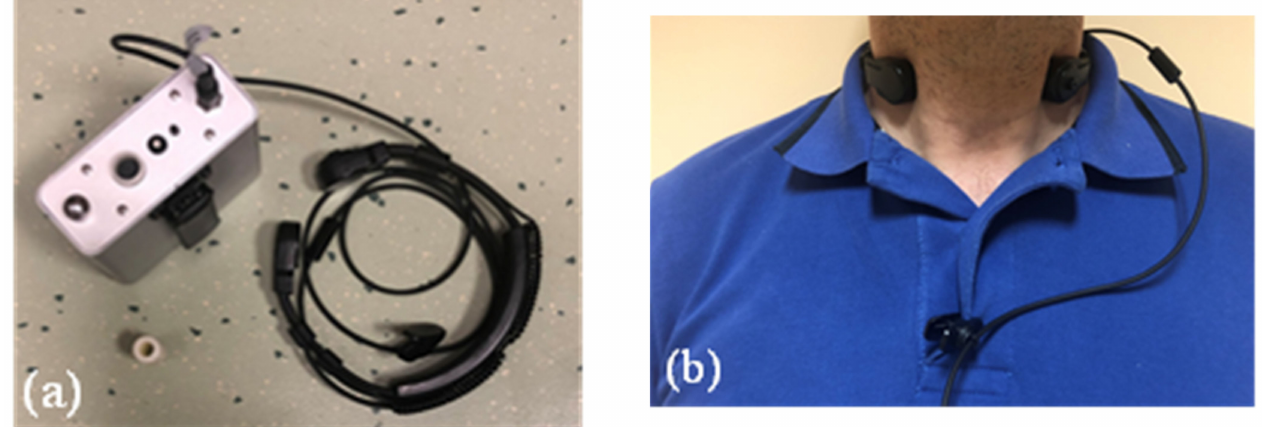
Figure 3. Vocal Holter Med (VHM) device ( a ) with a focus on the positioning of the contact micro- phone positioned at the neck by means of a collar ( b